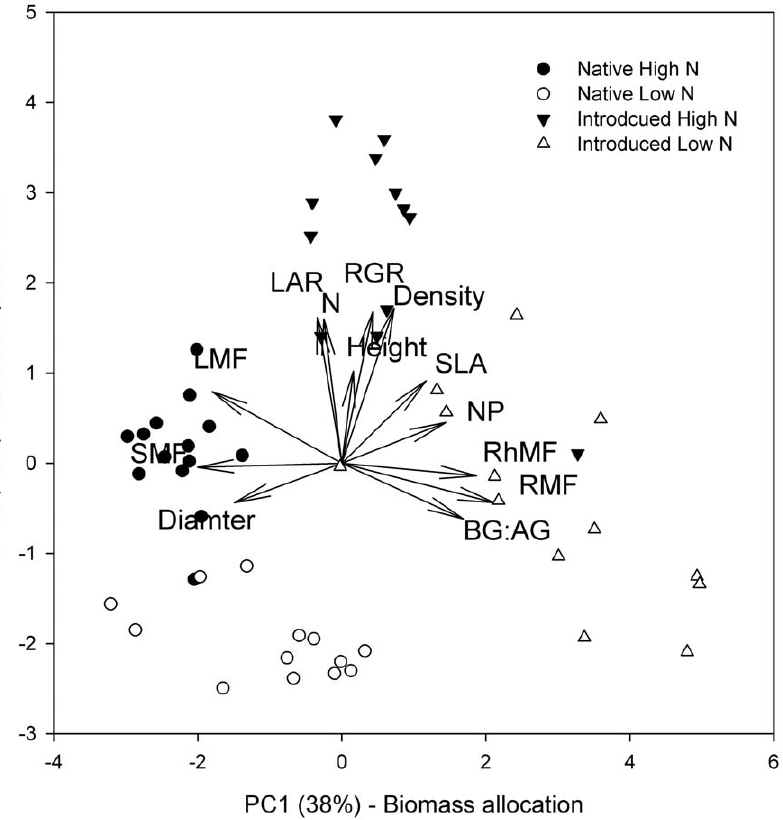
Figure 3. Principal component analysis of plant phenotype in response to CO 2 and N treatments. Circles indicate native Phragmites and triangles indicate introduced Phragmites . Filled symbols are indicative of N-treated plants. Axis 1 is interpreted as a biomass allocation and Axis 2 is interpreted as growth response to N.